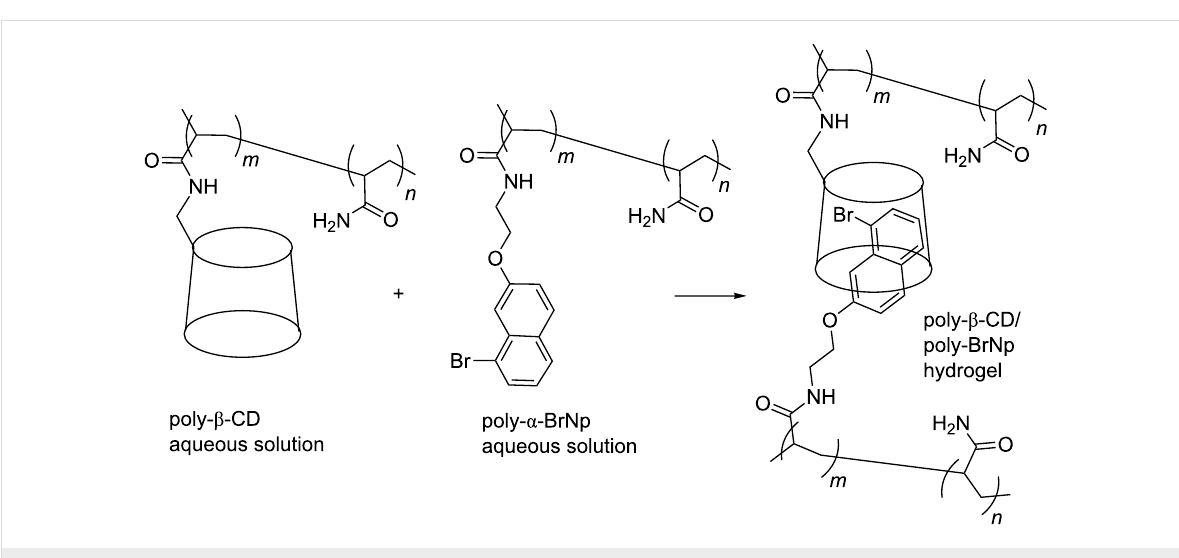
poly(acrylate), PAA-6 β -CD and randomly ferrocenyl substi- tuted poly(acrylate), PAA-Fc shown as (a) and (b),